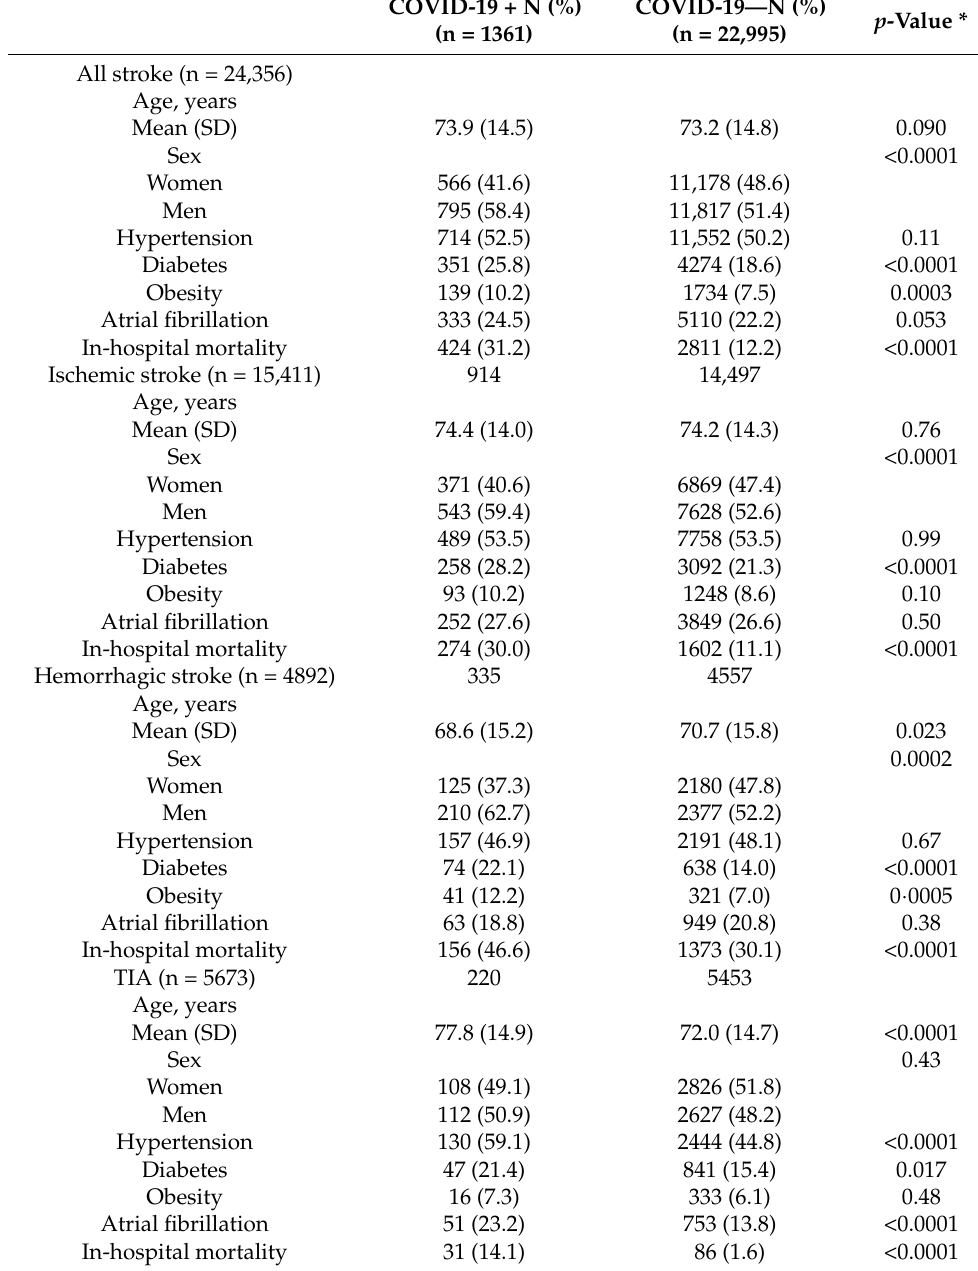
Table 2. Clinical characteristics of cerebrovascular events among COVID-19 vs. non-COVID-19 patients during the lockdown of